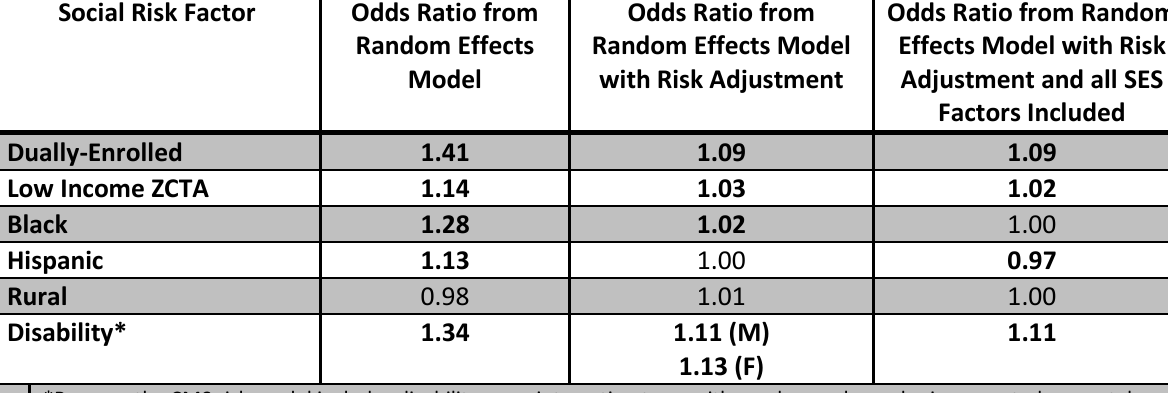
Table 13.4: Social Risk Factors and Re-Hospitalization, FYs